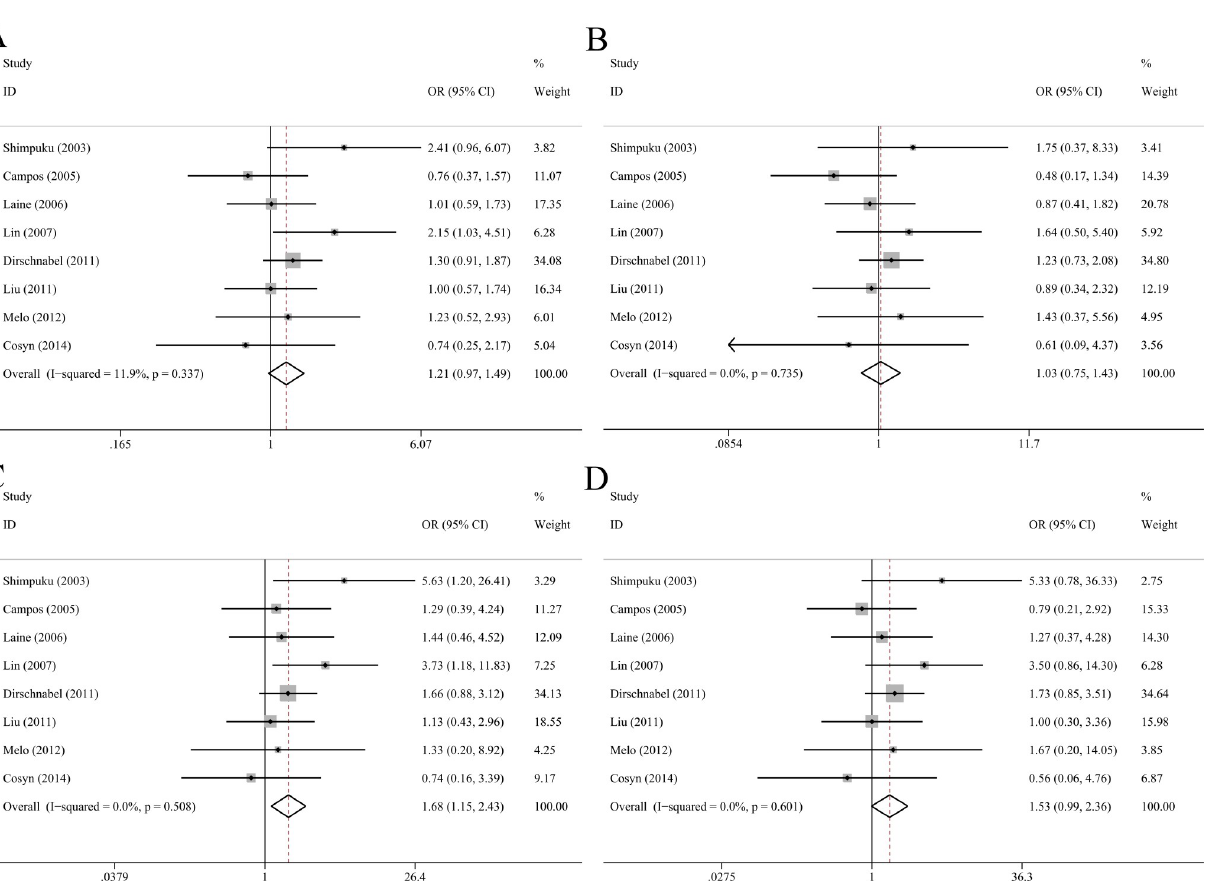
Fig 4. Forest plots of IL-1 β C-511T polymorphism with peri-implant disease risk in allelic (A), dominant (B), recessive (C) and homozygote model (D).